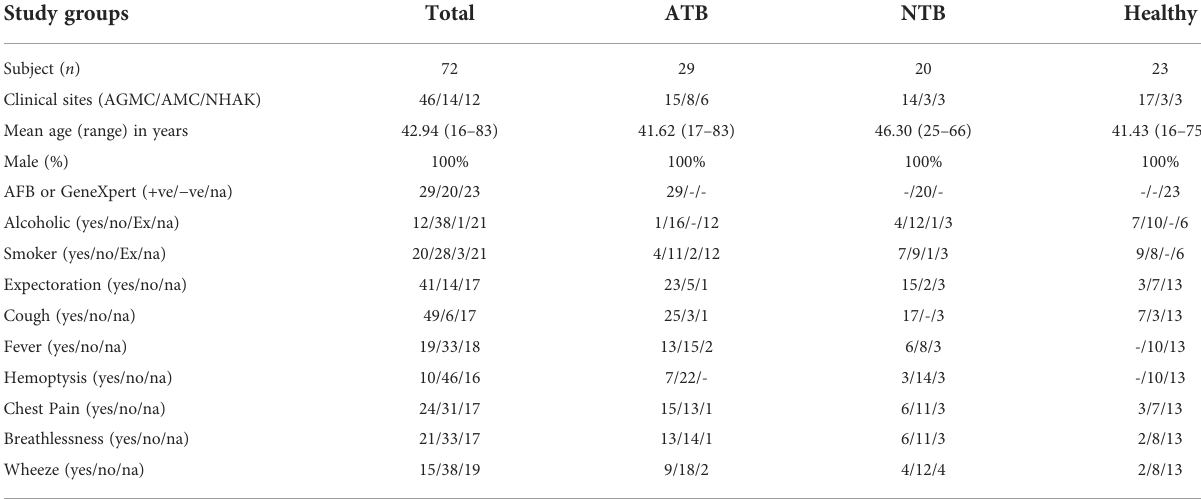
TABLE 1 Epidemiological details of the study subjects used in this study. Study groups